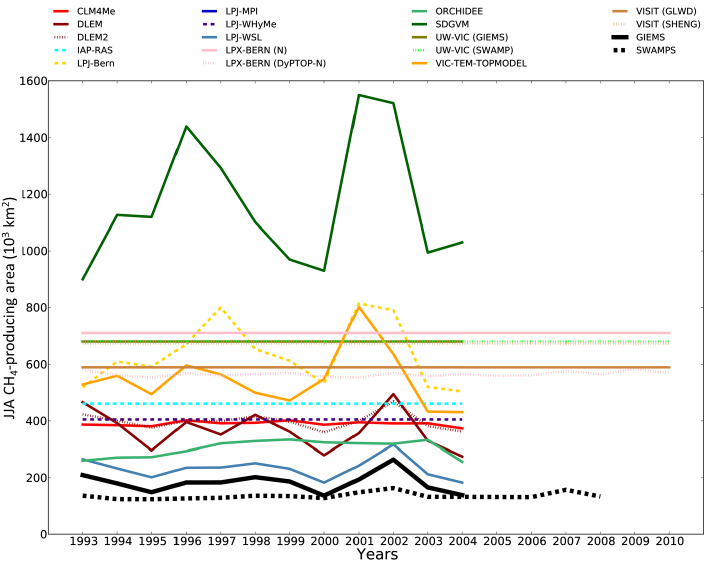
Figure 10. Time series of simulated JJA CH 4 -producing areas (10 3 km 2 ), with JJA surface water areas from GIEMS and SWAMPS products for